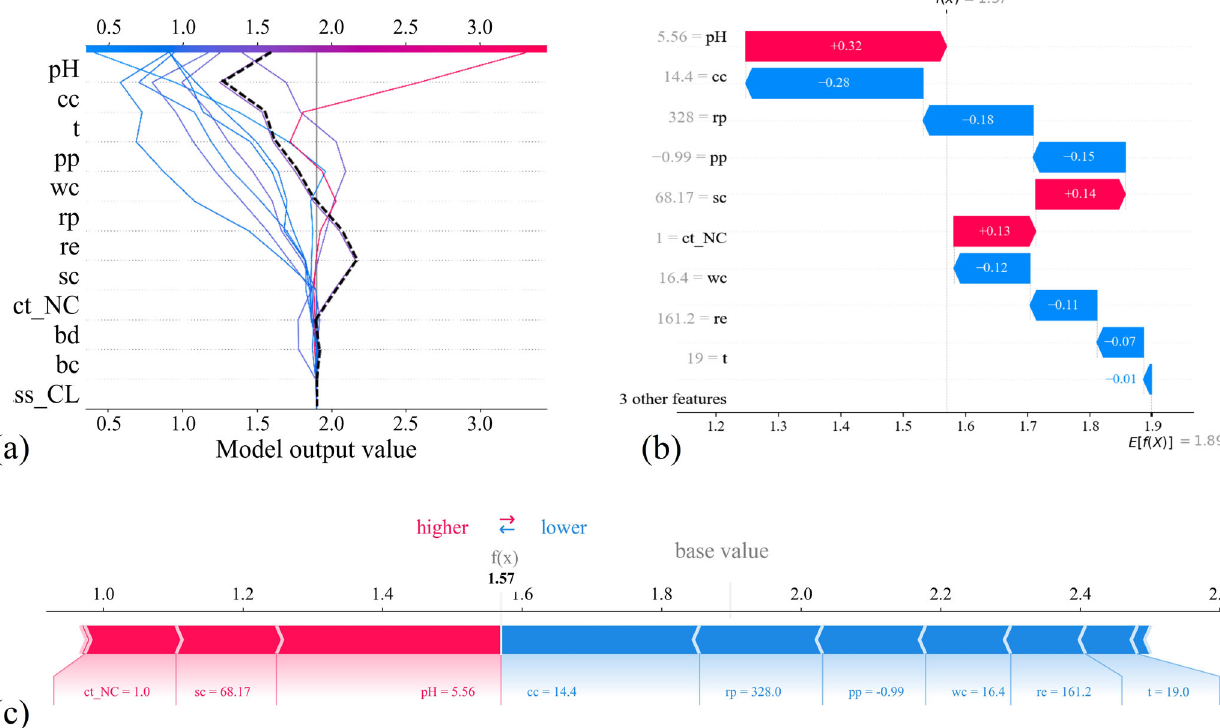
Fig. 8 SHAP local interpretation. a SHAP prediction lines for ten instances, b SHAP waterfall plot on selected instance, c SHAP force plot on selected instance. Published in partnership with CSCP and USTB npj Materials Degradation (2023)